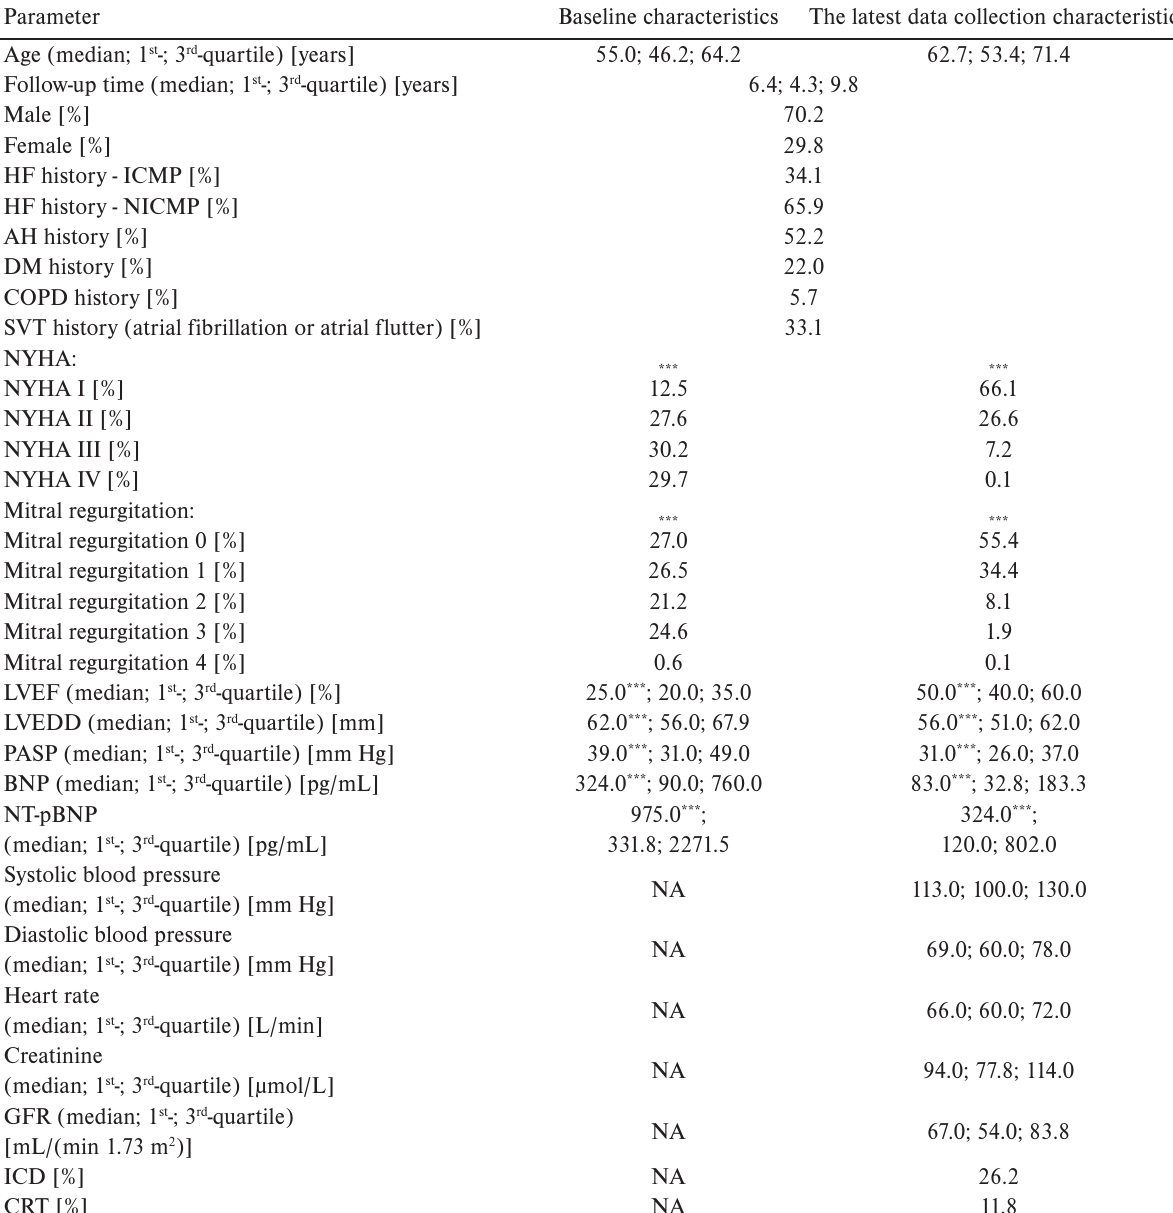
Table 1. Descriptive statistics and statistical comparison of obtained data. Parameter Baseline